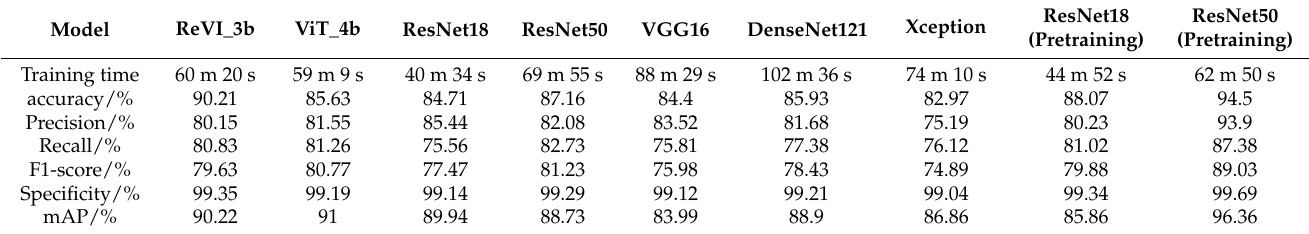
Table 4. Predicted results of ReVI_3b and other models on test set.